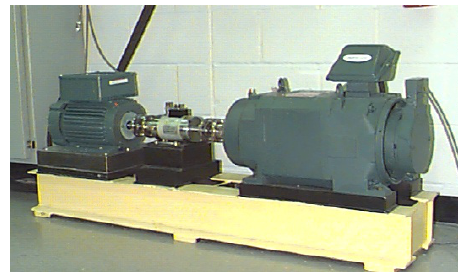
Figure 7. The rolling bearing test platform.